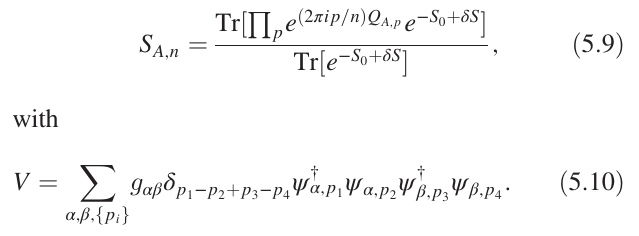
FIG. 8. (a),(b) Representative Feynman diagrams for calculat- ing h Q 2 , with (a) the noninteracting contribution and (b) the i c A first-order correction from interaction. Small circles represent the number operator Q . (c),(d) Diagrams involved in calculating A S in the replica analysis, focusing on the h Q 2 A;n contributes to the logarithmic divergence in I 2 . Small circles here correspond to pQ , where p is the replica momentum that is to A;p be summed over. The summation over p cancels all the interacting contributions, such as (d), leaving the noninteracting diagram in (c) as the only contribution. The quantization in I 2 thus survives the